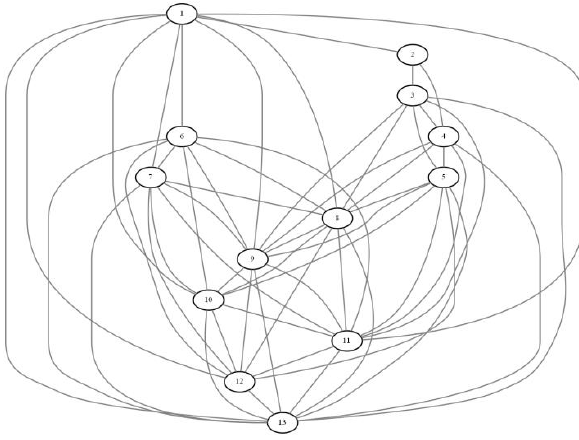
Figure 4. The connection graph after automated matching.